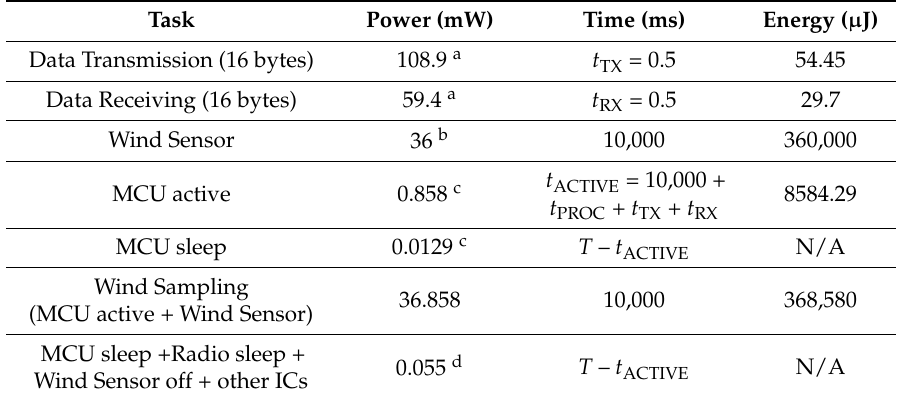
Table 1. Power and energy consumption for various tasks (figures taken from datasheet).